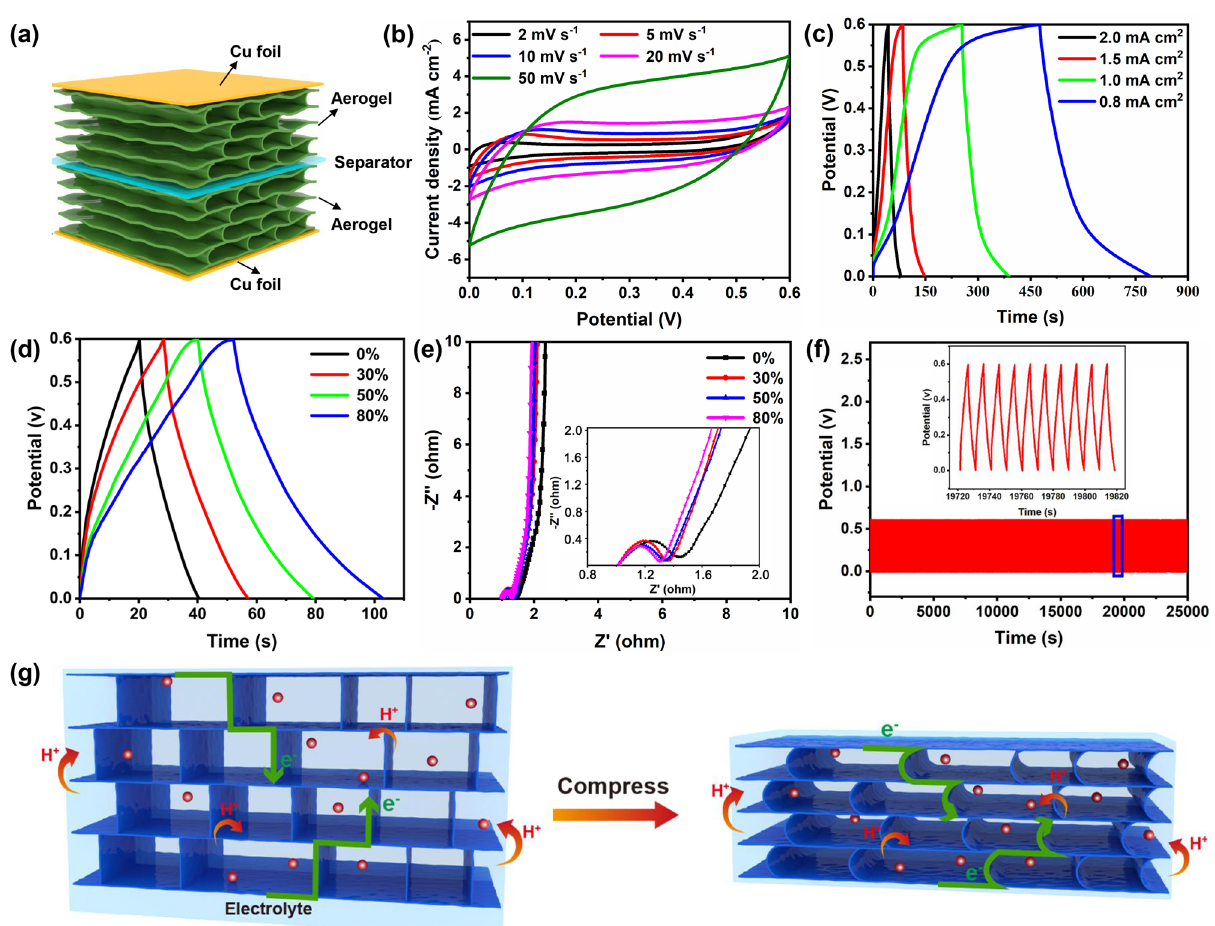
Fig. 5 a Schematic illustration of the assembled compressible supercapacitor. b CV curves of compressible supercapacitor at scan rates of 2–50 mV s −1 . c GCD curves at different areal current densities. d GCD curves and e Nyquist plots of compressible supercapacitor under various strains from 0 to 80%. f Cycling stability of solid-state compressible supercapacitors over 10,000 cycles under 30% strain. g The process illustra- tion of ions and electrons transport in electrodes before and after